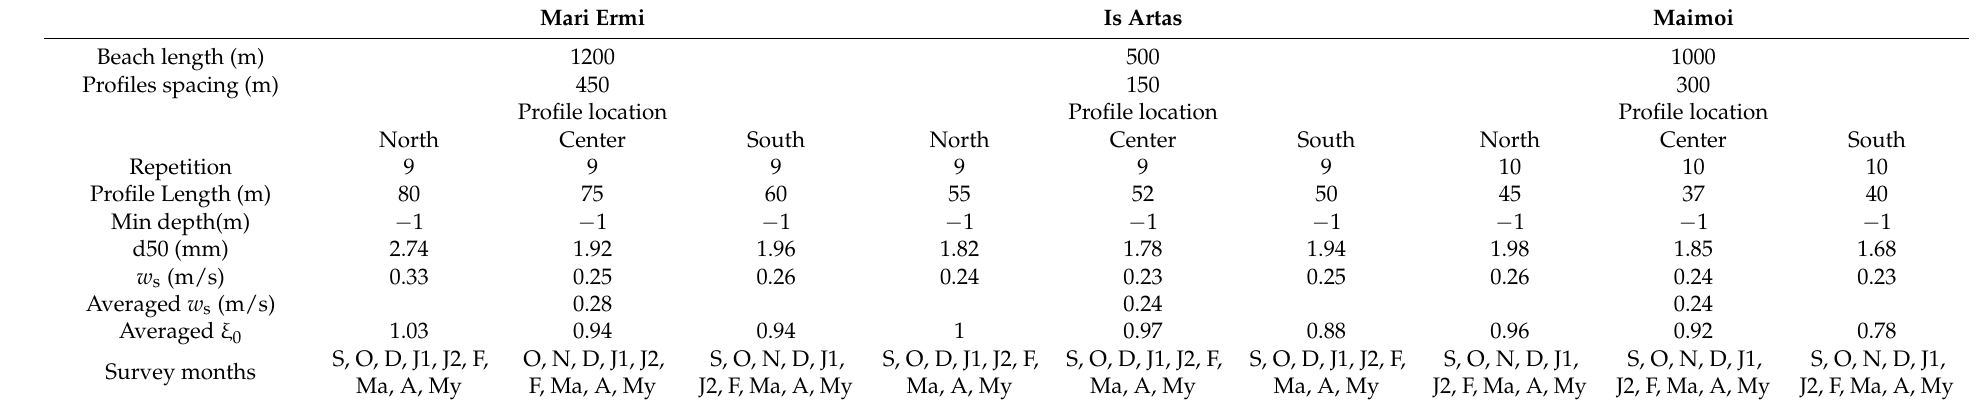
Table 1. A summary of the relevant characteristics of the studied beaches. The letters indicate the date of the topographic survey, as follows: S = 23 September 2010, O = 22 October